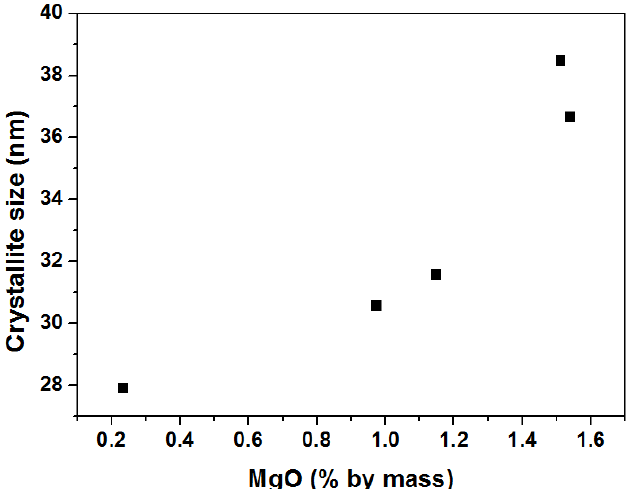
Figure 6. The size of iron crystallites related to the concentration of MgO in the precursor after